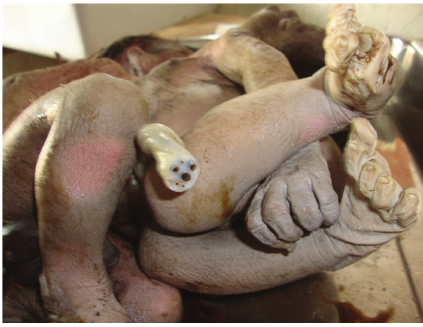
Figure 2: Photograph of umbilical cord.